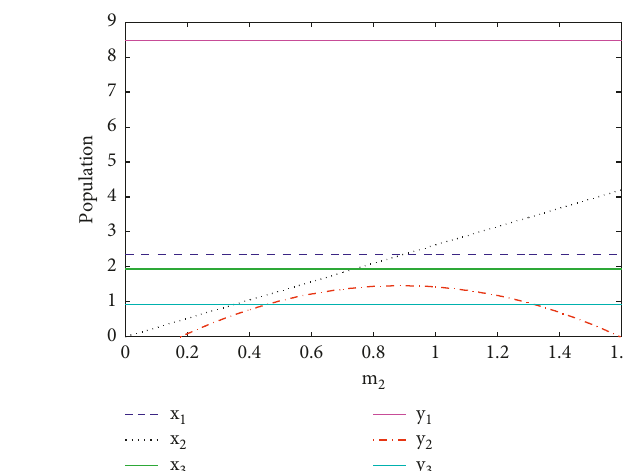
Figure 5: Behaviour of all species with respect to k